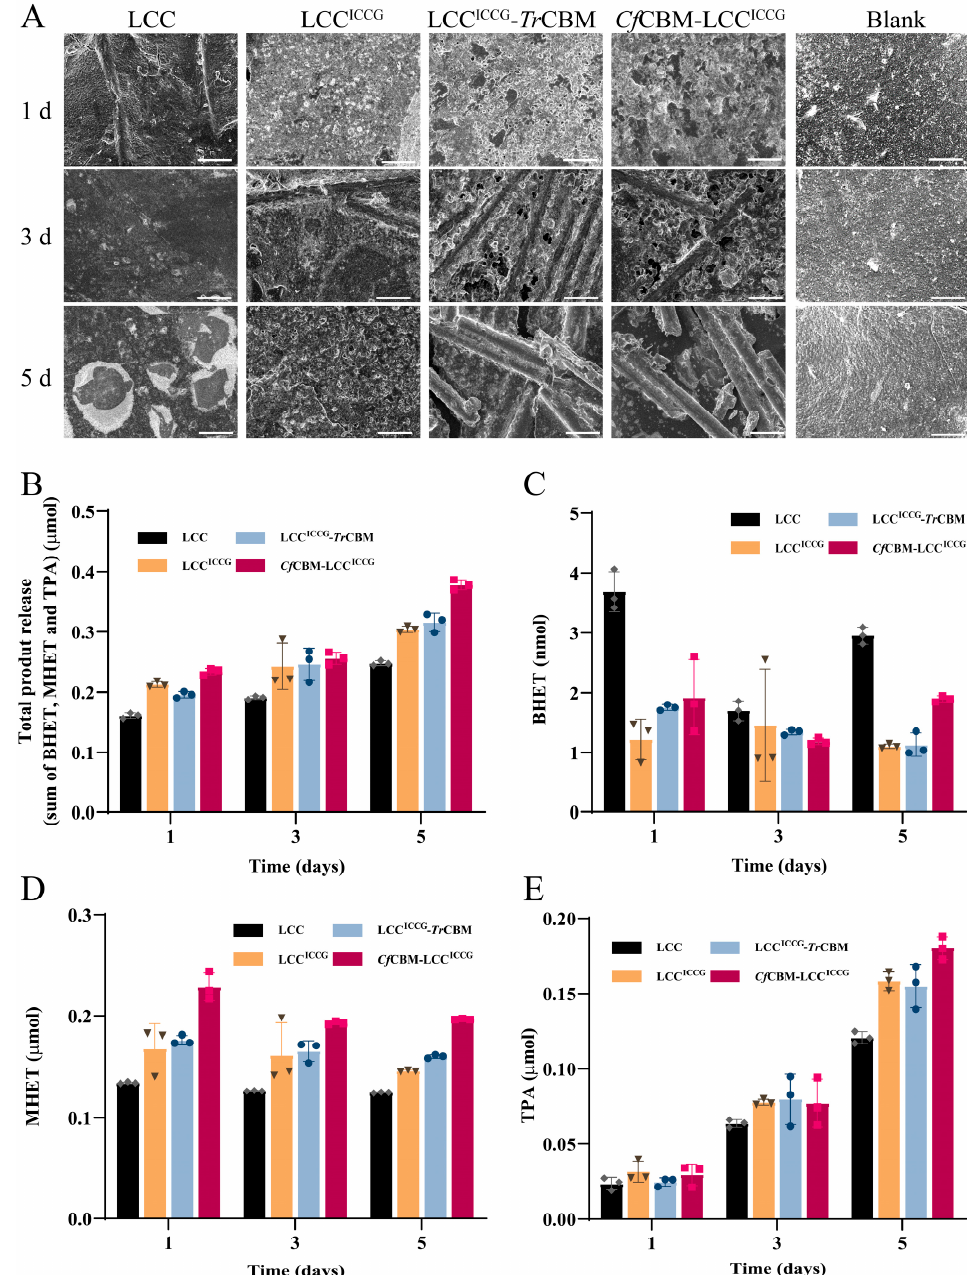
Figure 6. The degradation ability evaluation of fusion proteins on PET films. SEM morphologic analysis of PET films ( A ) recorded before and after enzymatic hydrolysis with LCC, LCC ICCG , LCC ICCG - Tr CBM and Cf CBM-LCC ICCG for 1, 3 and 5 days. Scale bar: 50 µ m. Release of total degradation products from PET films ( B ), including TPA ( C ), MHET ( D ) and BHET ( E ) after the treatment with LCC, LCCI CCG , LCC ICCG - Tr CBM and Cf CBM-LCC ICCG for 1, 3 and 5 days. In the experiment, 0.5 µ M of purified enzyme was incubated with 7 mg of PET films in 10 mL of potassium phosphate buffer (100 mM, pH 8.0) at 50 ◦ C and 120 rpm. Data were presented as mean value ± SD of triplicate experiments. Rhombus: LCC; inverted triangle: LCC ICCG ; circle: LCC ICCG - Tr CBM; square: Cf CBM-LCC ICCG